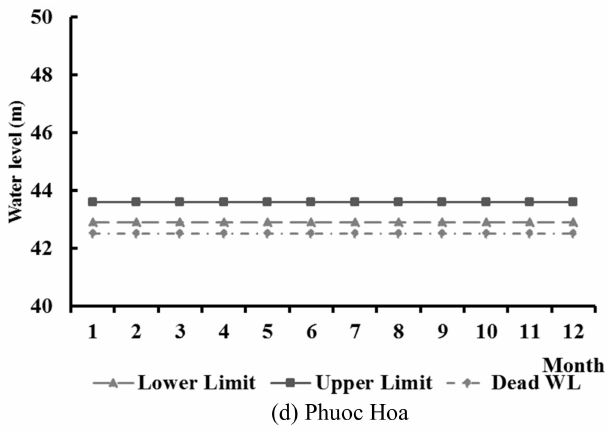
Figure 5. Operation rule curves of cascade